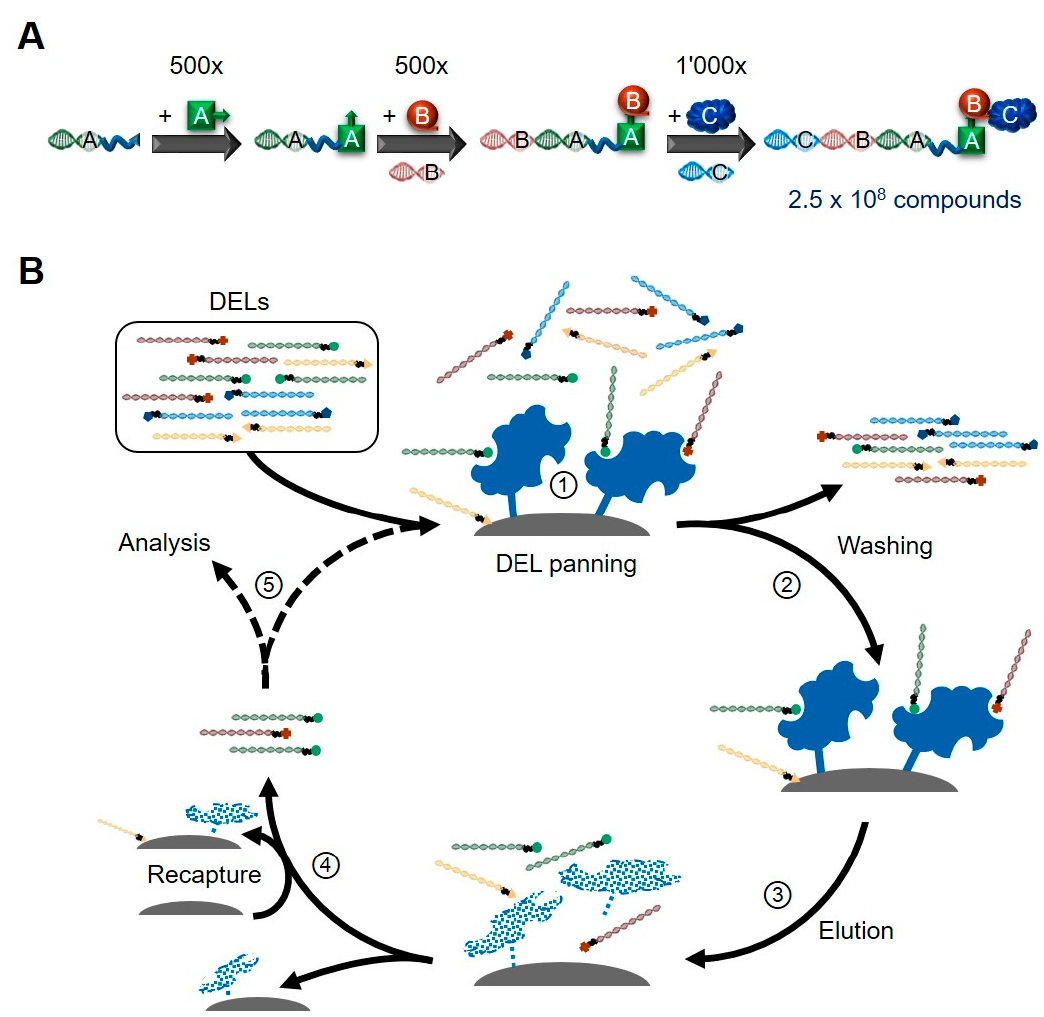
Figure 2. Schematic overviews of library construction and iterative DEL selection rounds ( A ) Employing the "split-and-pool" approach, very large DELs can be created. Shown is an example of combining three building blocks in parallel to the respective coding oligonucleotide fragments. ( B ) A typical DEL selection cycle consists of various steps: ① DELs are incubated with target proteins immobilized on solid support (matrix, e.g. magnetic beads). Alternatively, binding of DELs to the targets can be performed in solution prior to immobilization. ② Through various washing steps, non- binding or weakly-interacting compounds are removed and binding molecules retained. ③ Interactors are eluted from targets by specific or heat elution, breaking up the underlying interactions and partly denaturing and detaching the immobilized proteins. ④ To remove these detached proteins and compounds interacting with the matrix, a recapture step is performed with new matrix material. ⑤ The non-binding supernatant, containing the hits from the selection round, is either used for the next round of selection or as input material for PCR amplifications and analysis by NGS. Components are not drawn to scale.